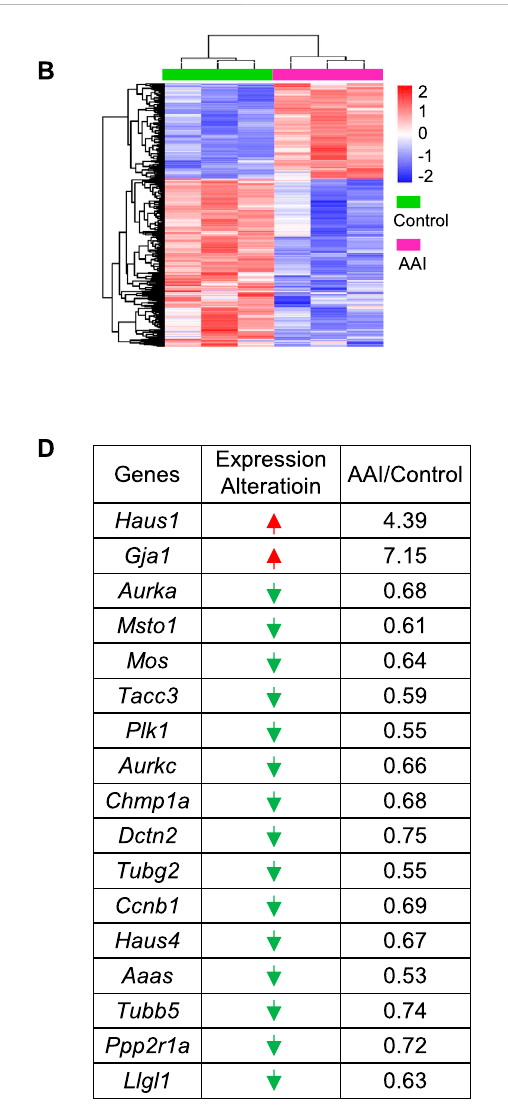
FIGURE 5 AAI exposure disturbs the expression of genes involved in spindle organization/orientation in GVBD oocytes. (A) The fully grown GV oocytes were matured in the M16 medium containing 0 or 50 μ M AAI for 2 h to reach the GVBD stage. Oocytes were collected for RNA-seq. PCA analysis of RNA-seq data grouped controls and AAI treatments into two separate clusters. Each data point represents one experiment. (B) The heatmap of differentiallyexpressedgenes(DEGs)betweenthecontrolandAAI-exposedgroups. (C) Thetop10GO-BPtermsofDEGs. (D) ThelistofDEGsin the spindle assembly/orientation term in (C) . Red arrow, upregulated; green arrow, downregulated.